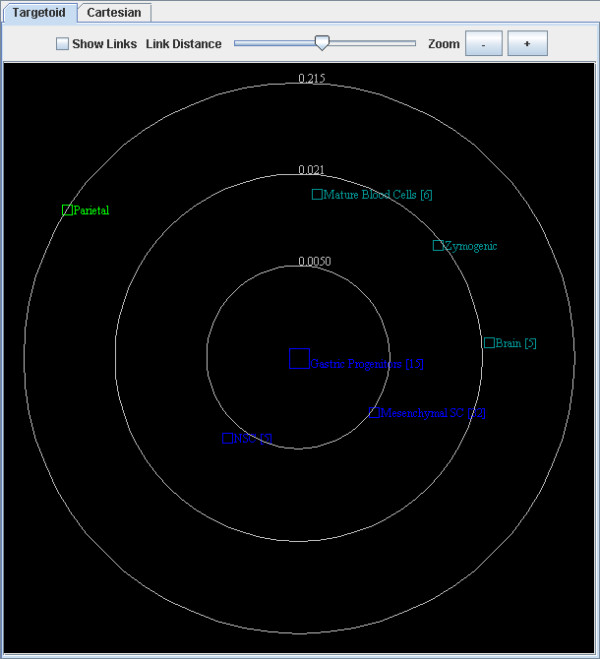
The GOurmet Cartography Targetoid plotting window. Depicted is a screen shot where the sample GEP profile has been chosen as a center element (center elements are selectable in the dendrogram window), and all other profiles radiate outward in direct inverse proportion to how similar they are to GEPs. Note how GEPs are more similar to the other two stem/progenitor profiles and more distant from all the profiles of differentiated cells. Relationships among non-center elements are only approximately reflective of their similarity and are depicted by how far apart they are from each other (θ angle between elements in this polar coordinate system). Any profile can be selected as the center and, by multiply selecting different profiles, users can reconstruct all the direct relationships among the various profiles. A sliding bar allows the user to focus on certain regions of the targetoid space (important for visualization when large numbers of profiles are compared at once and many similar ones cluster closely together); users can also adjust the axial scale. The targetoid plot can be output as a jpeg.